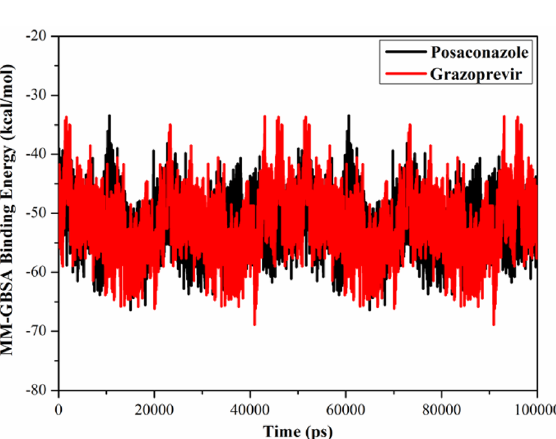
Figure 5. Evaluated MM-GBSA binding energy per frame for posaconazole (in black) and grazoprevir (in red) towards SARS-CoV-2 helicase throughout 100 ns MD